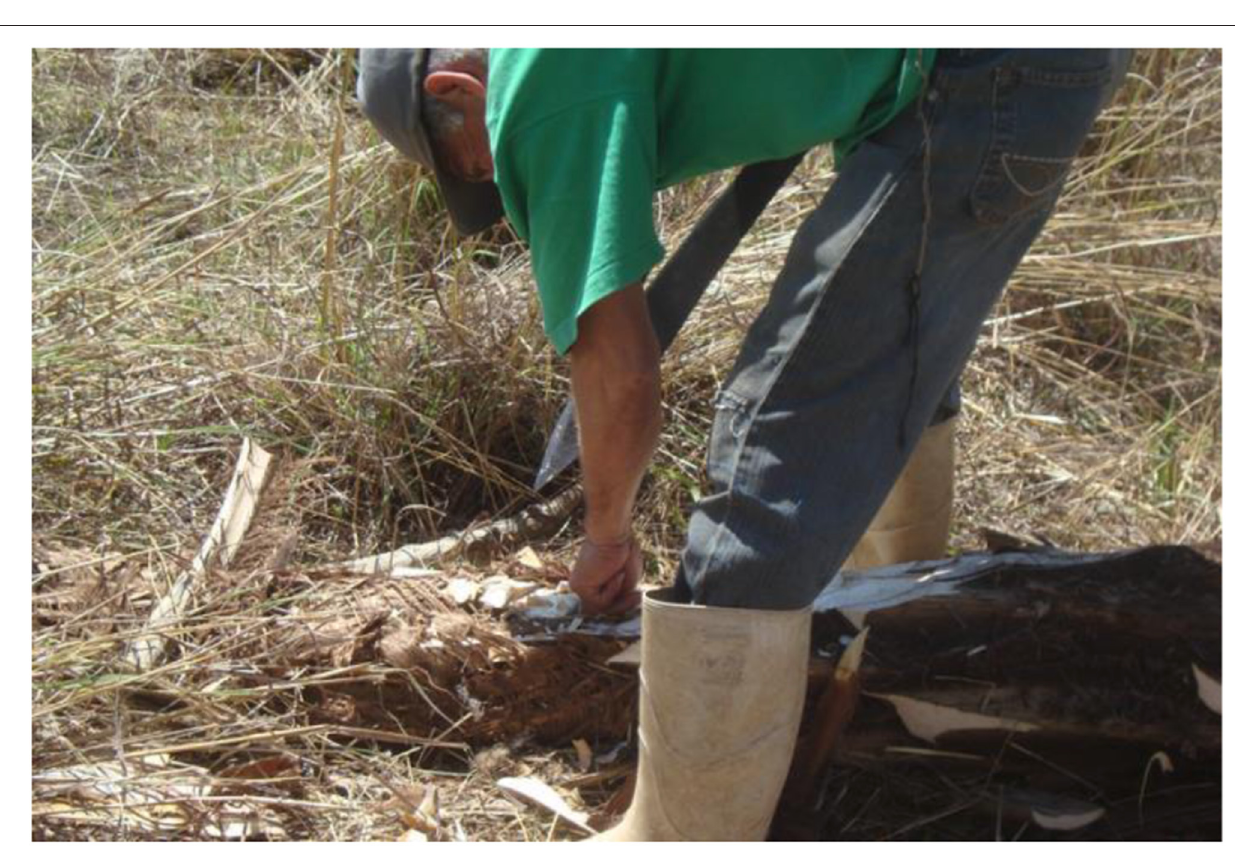
Frontiers in Sustainable Food Systems |